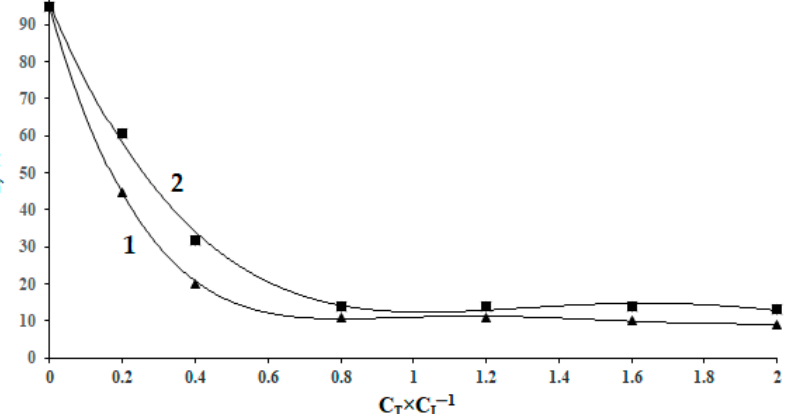
Figure 5. Dependence of the yield of tetramethylsuccinonitrile on the ratio of the concentrations of sulfanylethanoic acid—1 (3-sulfanylpropanoic acid—2) and AIBN after heating for 20 h at a temperature of 353 K.